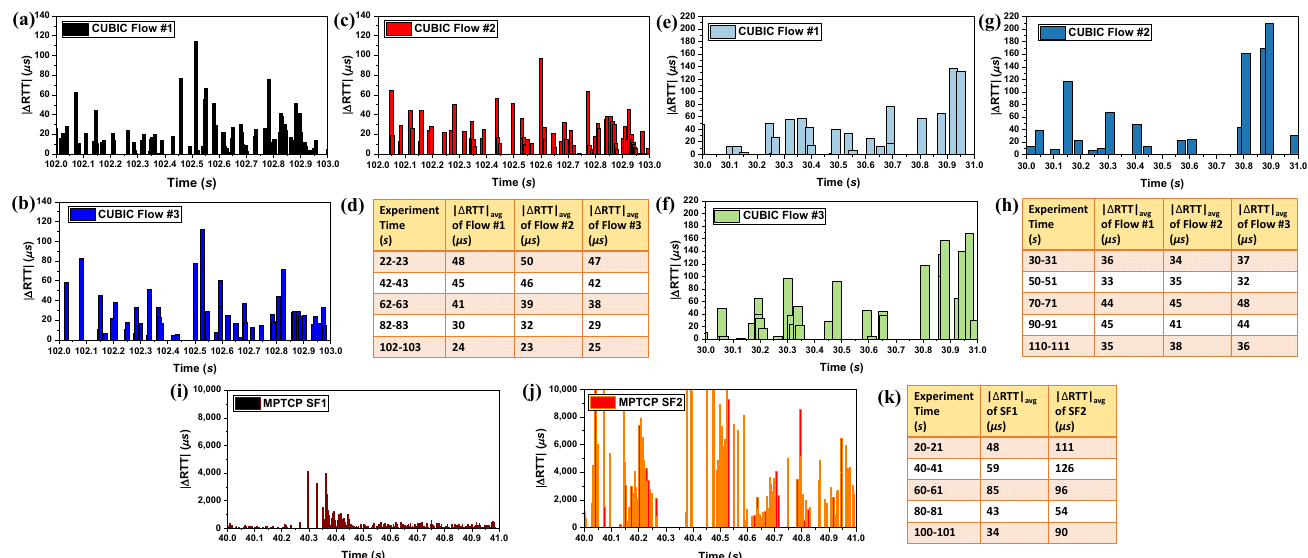
Figure 3. | ∆ RTT | and | ∆ RTT | for the simple experimental analysis. ( a – c ), ( e – g ), and ( i , j ) show the | ∆ RTT | for three CU- BIC flows for Scenarios #1 and #2, and two MPTCP SFs for Scenario #3, respectively. ( d , h , k ) show the | ∆ RTT | during different intervals for the three CUBIC flows for Scenario #1 and #2, and two SFs for Scenario #3, respec- tively.